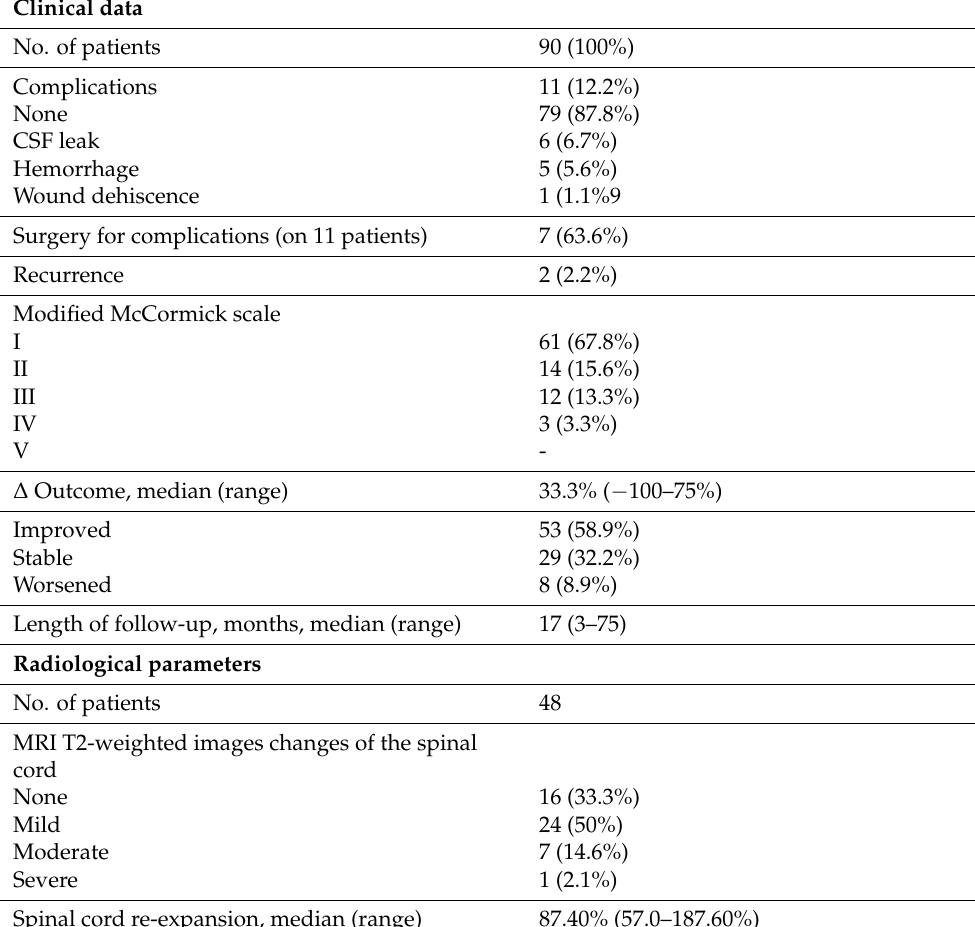
Table 4. Postoperative clinical and radiological features of the patient